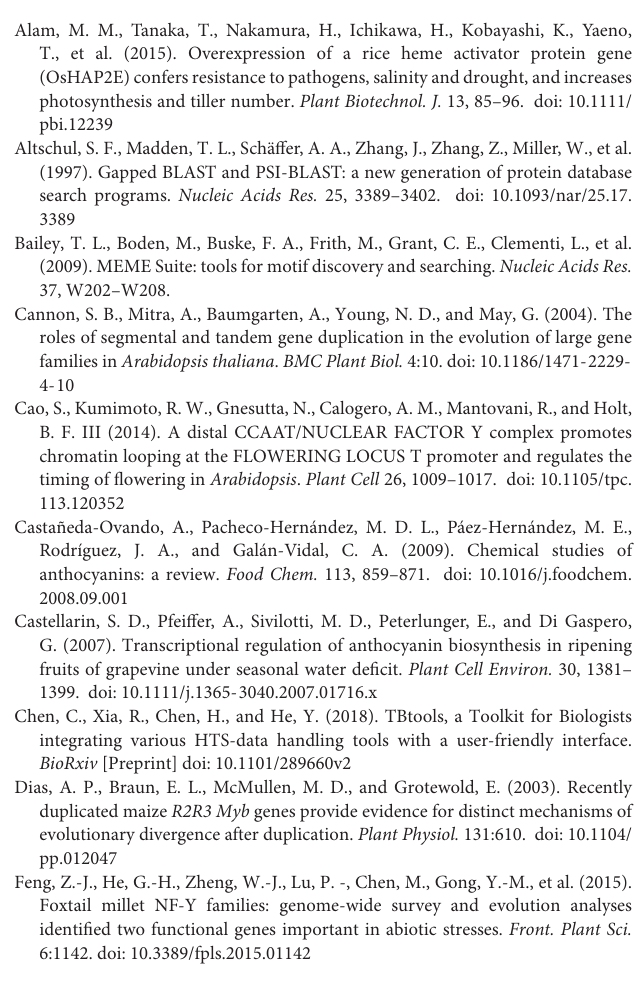
Supplementary Table 2 | Characteristic features of 41 StNF-Y genes.